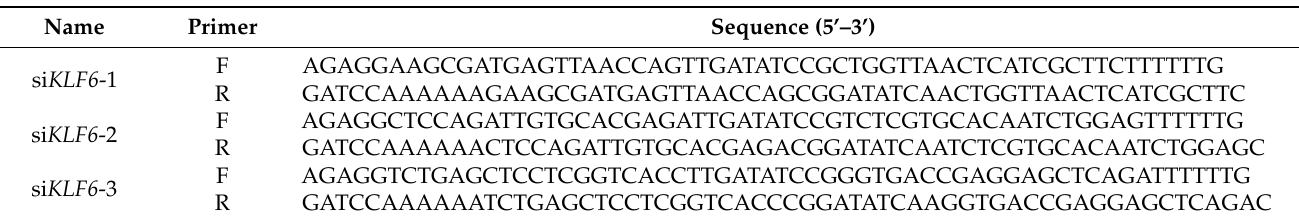
Table 3. Small interfering RNA (siRNA) sequences for KLF6